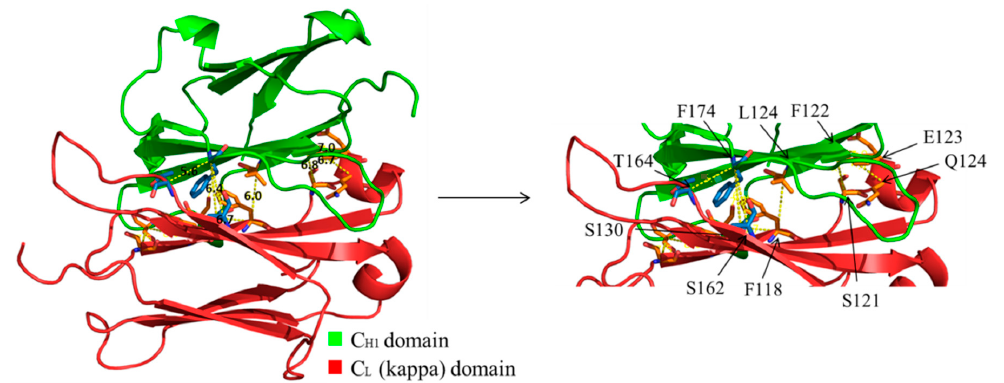
Figure 1. C H1 -C L interface with the potential positions for a stabilizing disulfide bond formation. C H1 and C L domains (of Light chain kappa chain) are presented colored green and red, respectively, with the potential positions for disulfide bond formation at the C H1 -C L interface. Table 1. The selected positions for introducing cysteine mutations in domains C H1 and C L . The C α - C α distance between the residues of each pair is indicated.